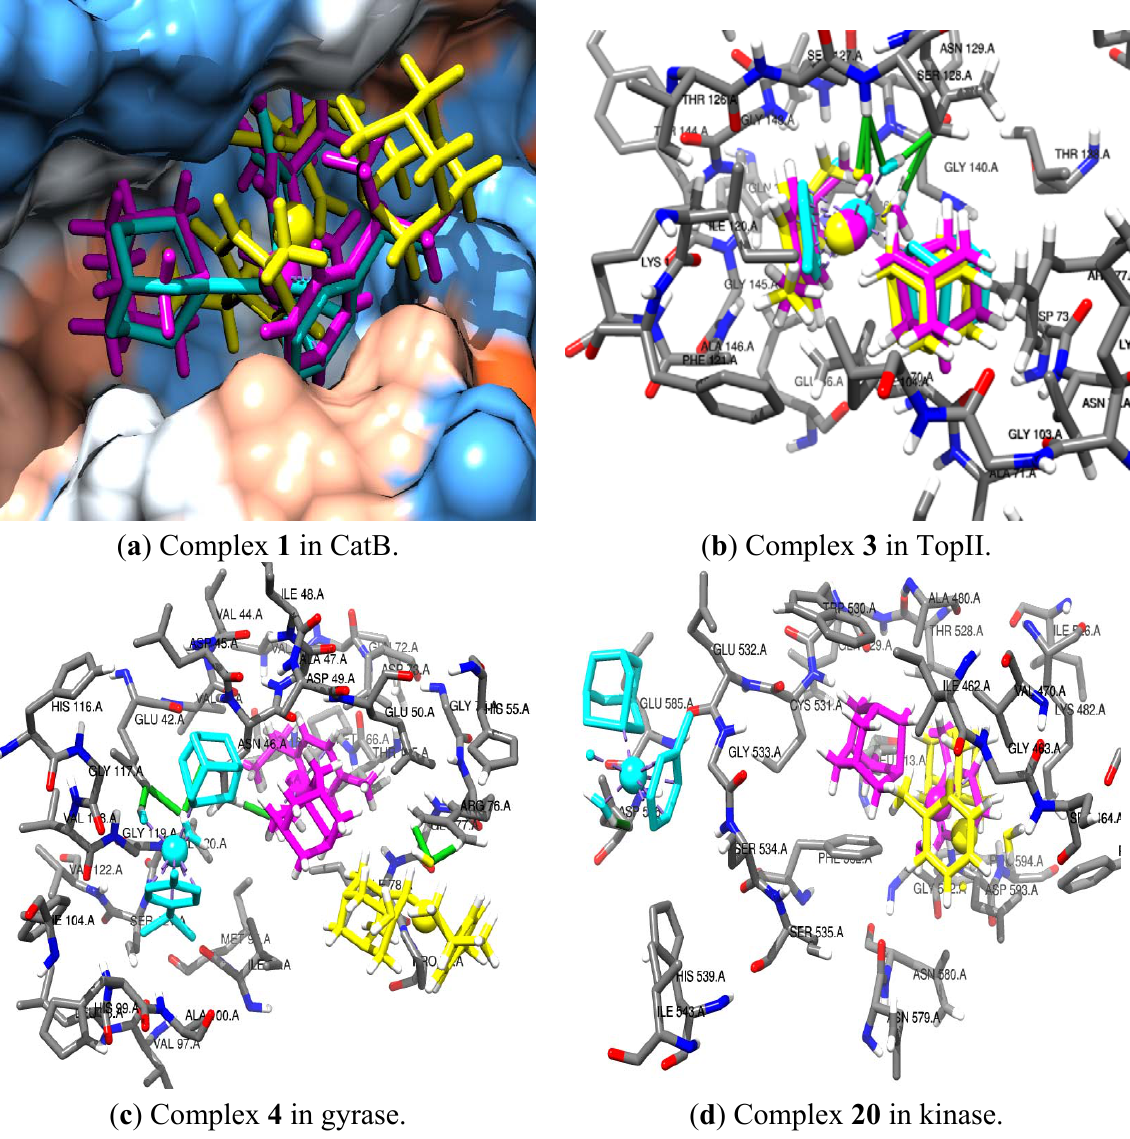
Figure 1. The binding site interaction of complexes 1 , 3 , 4 and 20 with CatB, TopII, gyrase and kinase, respectively, using Autodock (cyan), Gold (magenta) and Glide (yellow) docking predictions. The colouring of the CatB surface as Figure 1a is from the hydrophilic (red) to hydrophobic (blue) and the HB is represented with green cylinders in Figure 1b–d.